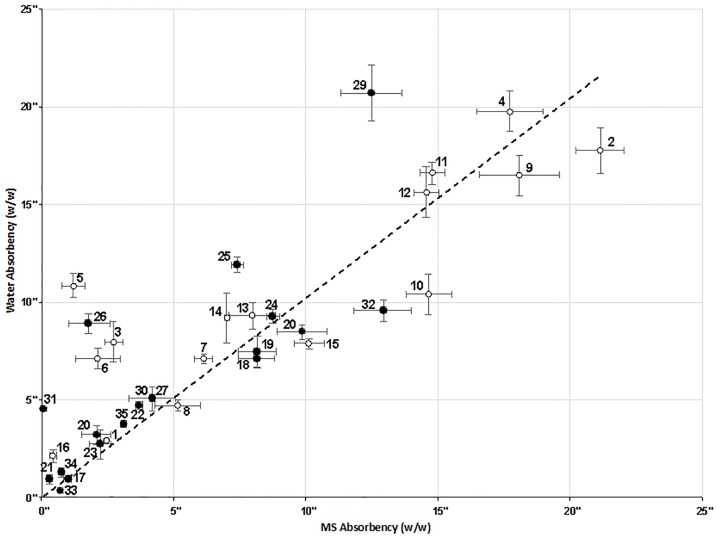
Performance of clinical (1–16; open circles) and domestic (17–35; filled circles) products in terms of ability to absorb water or methyl salicylate (expressed as weight of MS or water absorbed per weight of test product; w/w).All values are mean ± standard deviation of n = 7 measurements. Products 2, 12, 15 and 16 were selected for in vitro skin studies. For a description of each product (1–35), see Table 1.